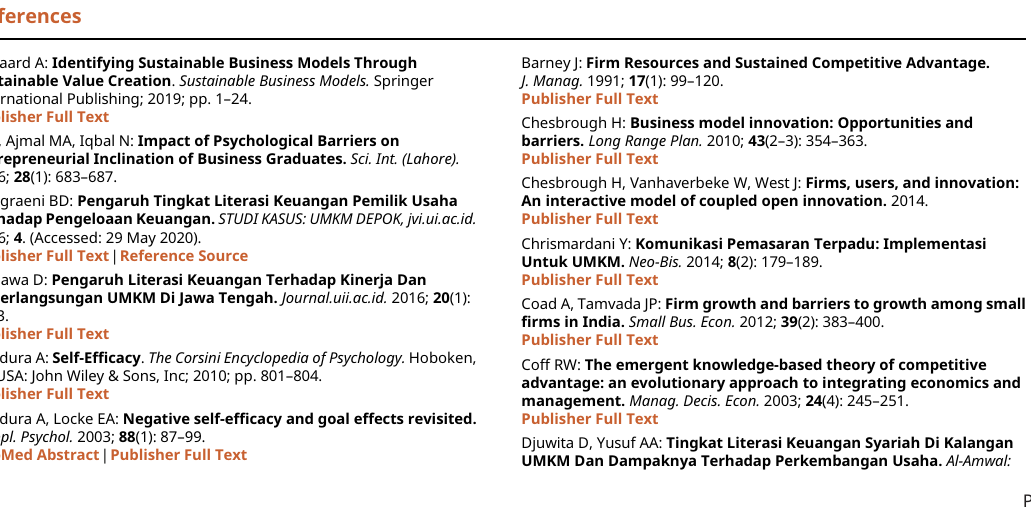
Figshare: List of questions and description of the